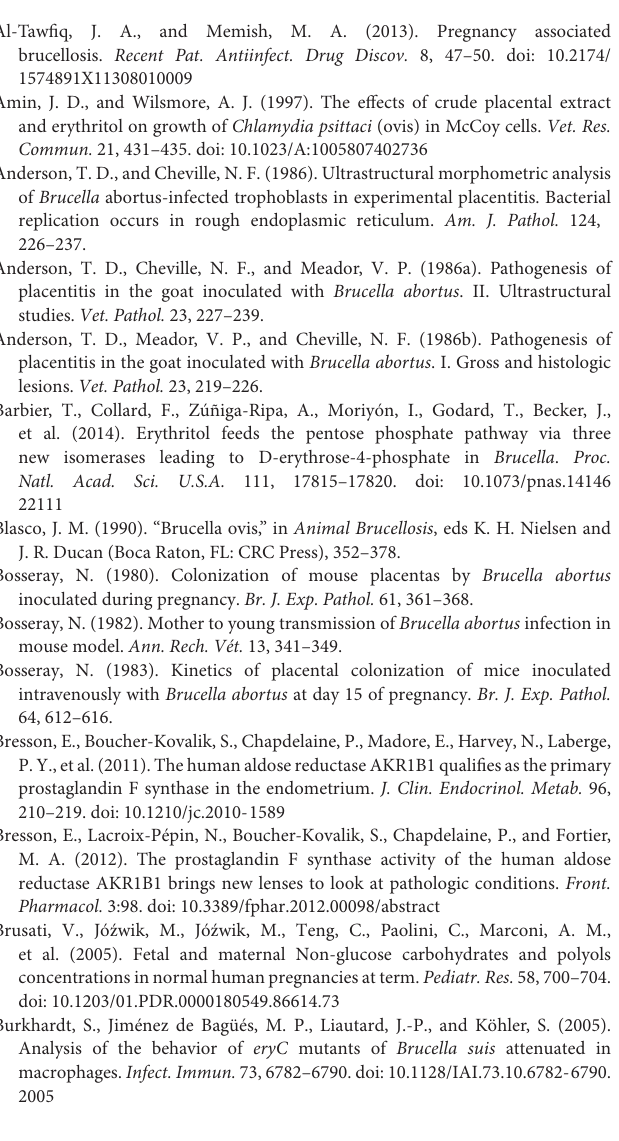
FIGURE S1 | Brucella abortus 2308 (cid:49) eryA and (cid:49) eryH are not able to grow with erythritol as the only carbon source. The growth of the (cid:49) eryA mutant was monitored in rich medium 2YT or in chemically defined medium with erythritol as the only carbon source and compared to (cid:49) eryH {Barbier:2014 cm}. As expected, the growth of the deletion strains is abolished when only erythritol is available. FIGURE S2 | The growth of the erythritol-sensitive B. abortus 2308 (cid:49) eryH strain is not affected by other polyols. Growth was monitored in 2YT supplemented with polyols structurally close to erythritol that are also found in fetal fluids and tissues. The growth of the (cid:49) eryH mutant was not affected by any of the polyols tested